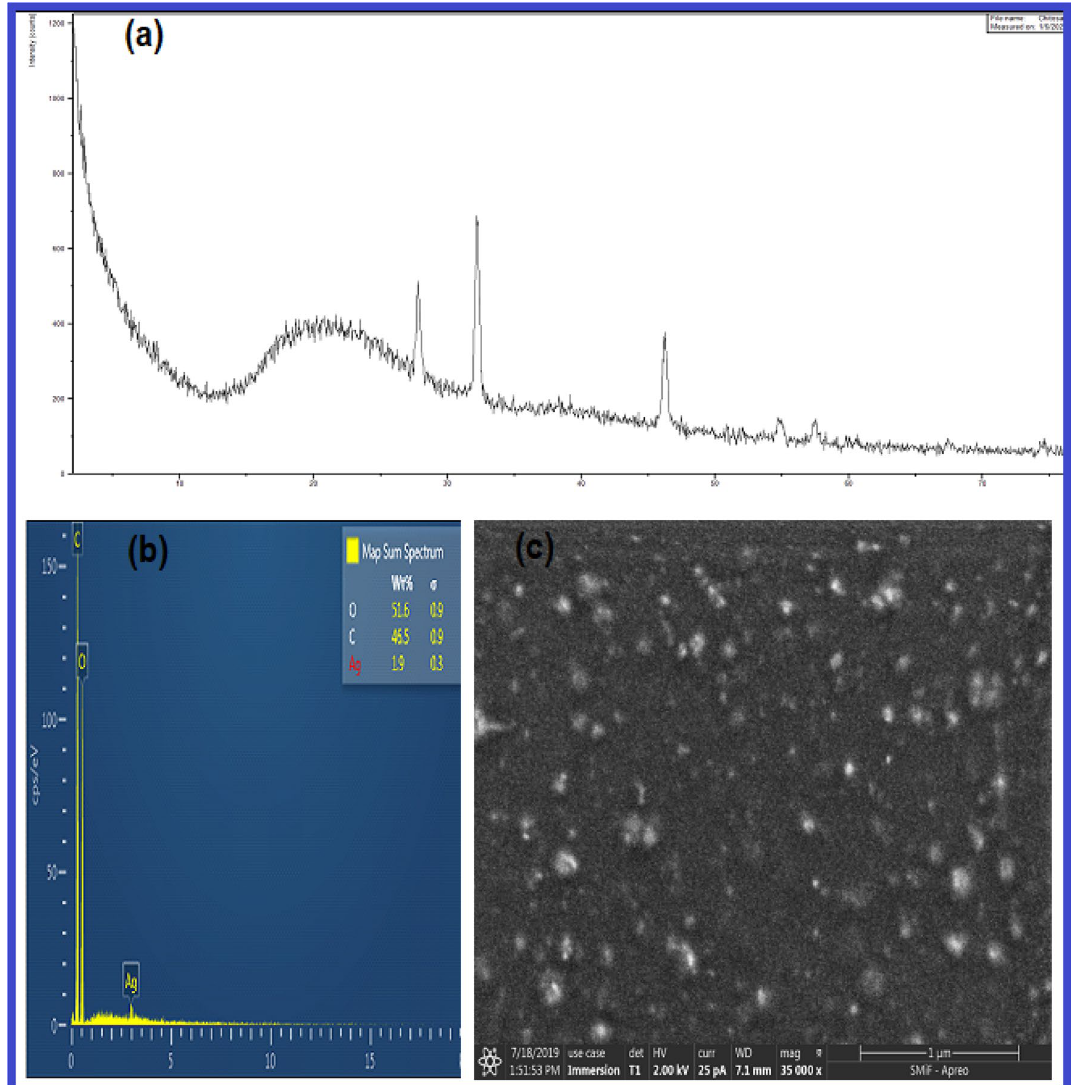
Figure 4. XRD pattern of (a) EDS elemental analysis; (b) SEM; (c) image of the AgNPs@C_MA_O obtained from dryed spincoated of AgNPs was found as a 0.01 mg/mL, which is 33 times less than previously reported IC 50 , as 0.33 mg/mL 14 , 0.78 − 6.25 μg/mL and 12.5 mg/mL 37 , 10.6 and 11.6 mg/mL 38 , 5 µg/mL 39 and 64.5 μg/mL 40 for different func-